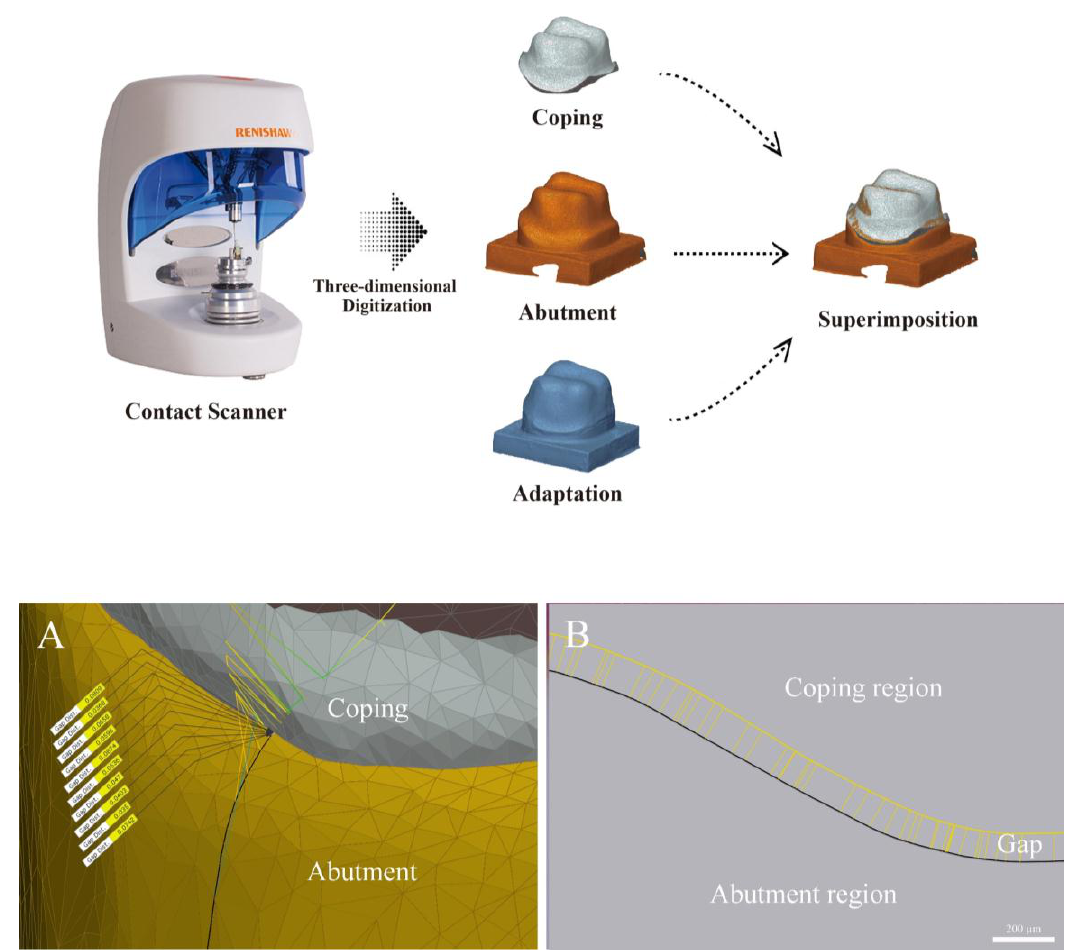
Figure 6. Schematic of the triple scan method (TSM). ( A ) Three-dimensional image; ( B ) cross-sectional image of the TSM for the occlusal gap.